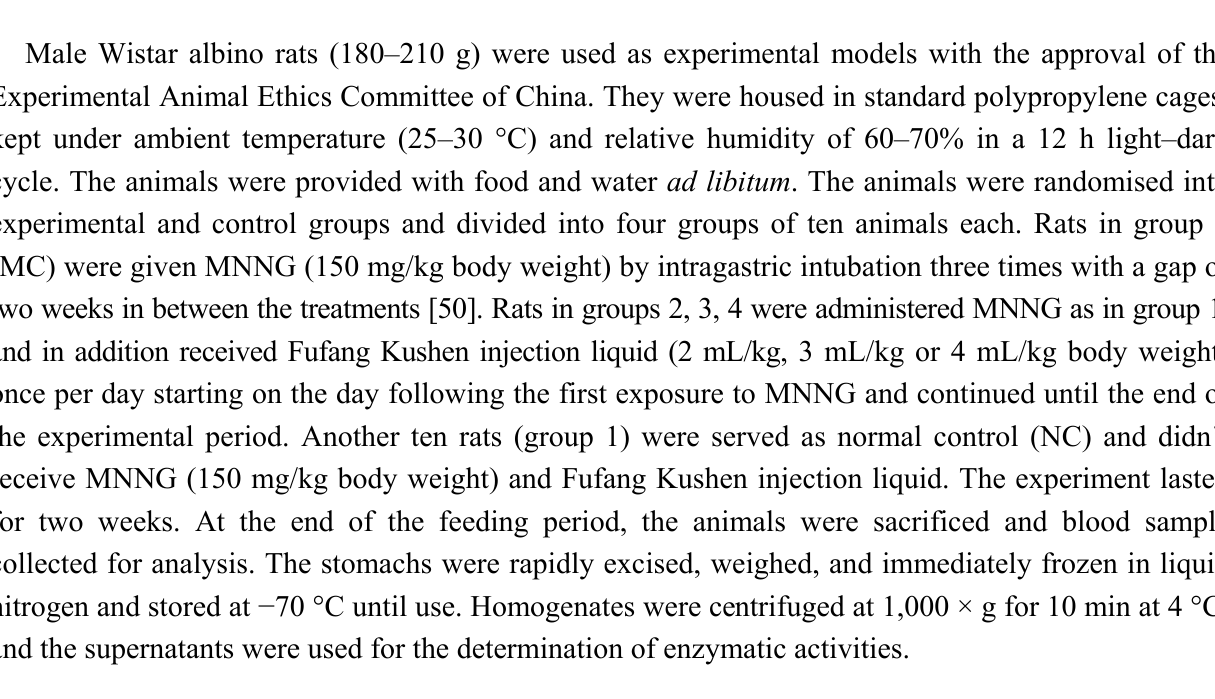
Table 5. Effect of FFKSIL treatment on serum and gastric mucosa SOD, CAT, GSH-Px activities. SOD CAT GSH-Px Group Gastric Gastric Gastric Serum Serum Serum mucosa mucosa mucosa NC 201.5 ± 18.38 174.3 ± 12.69 45.26 ± 2.68 38.29 ± 1.58 52.16 ± 3.52 47.73 ± 2.68 MC 137.2 ± 11.32 b 103.2 ± 8.49 b 23.18 ± 1.65 b 17.04 ± 1.21 b 28.38 ± 1.69 b 25.81 ± 2.01 b FFKSIL (2 mL/kg b.w.) 170.5 ± 10.63 d 139.5 ± 8.84 d 33.29 ± 1.48 d 24.72 ± 1.59 d 39.91 ± 1.93 d 31.54 ± 1.82 d FFKSIL (3 mL/kg b.w.) 188.3 ± 13.29 d 158.3 ± 10.42 d 39.17 ± 1.77 d 30.14 ± 1.99 d 44.73 ± 2.64 d 39.54 ± 1.95 d FFKSIL (4 mL/kg b.w.) 197.2 ± 13.09 d 177.2 ± 11.43 d 48.32 ± 2.07 d 39.12 ± 2.14 d 49.81 ± 3.32 d 49.03 ± 2.49 d b p < 0.01, compared with group NC; d p < 0.01, compared with group